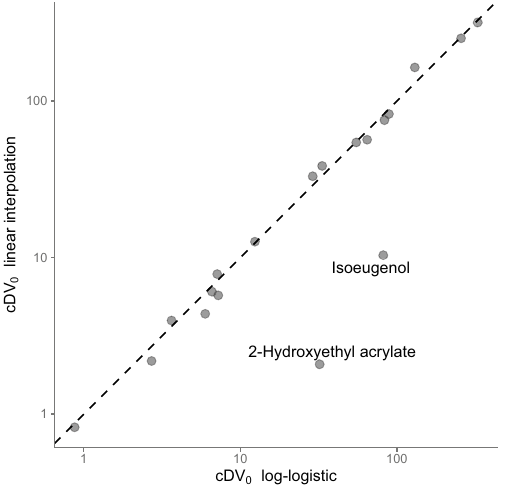
Figure 2. Comparison between the cDV 0 estimation procedures. The scatter plot describes cDV 0 values that were determined using either log-logistic modelling (x-axis) or linear interpolation (y-axis). The dashed line represents the identity line.